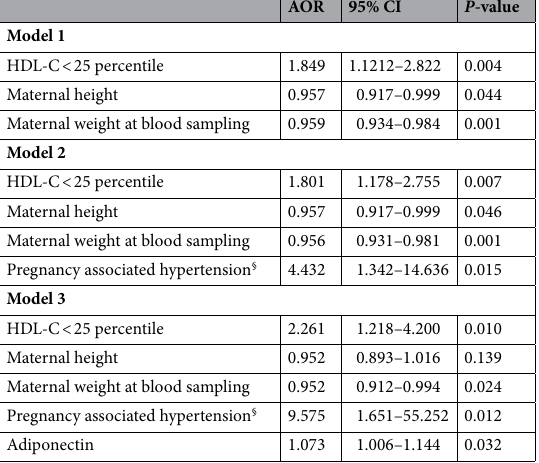
Table 3. The relationship between maternal serum high-density lipoprotein cholesterol (HDL-C) at 10–14 weeks of gestational age (fasting condition) and SGA, analyzed by multiple logistic regression analysis*. * Via enter method after adjustment for clinical and other metabolic serum markers including maternal height and weight at blood sampling, presence of gestational hypertension, and adiponectin. § Includes gestational hypertension or preeclampsia.